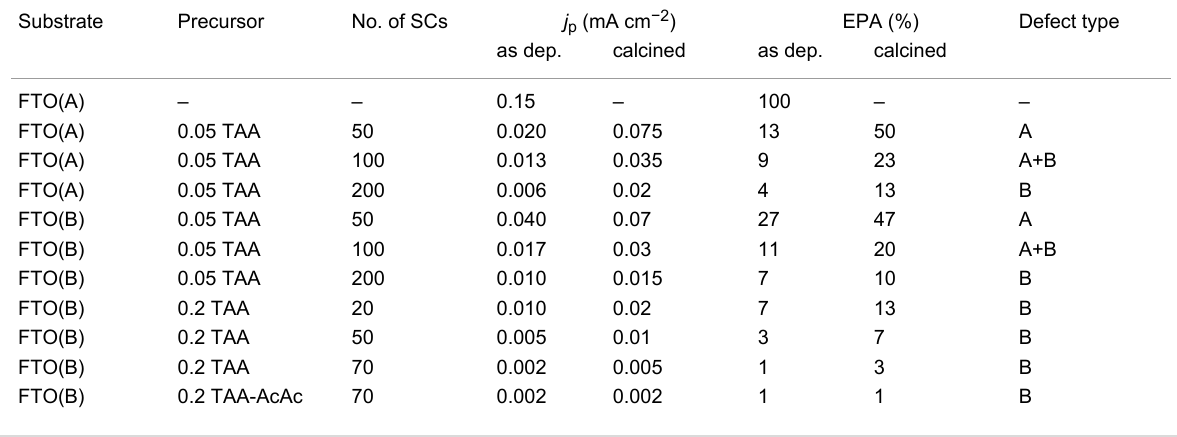
Table 2: Analysis of the effective pinhole area for our as-deposited and post-calcined TiO 2 films. Data from cyclic voltammetry of Fe(CN) 63 − /4 − ; scan rate 50 mV/s (experimental conditions same as in Figure 2).